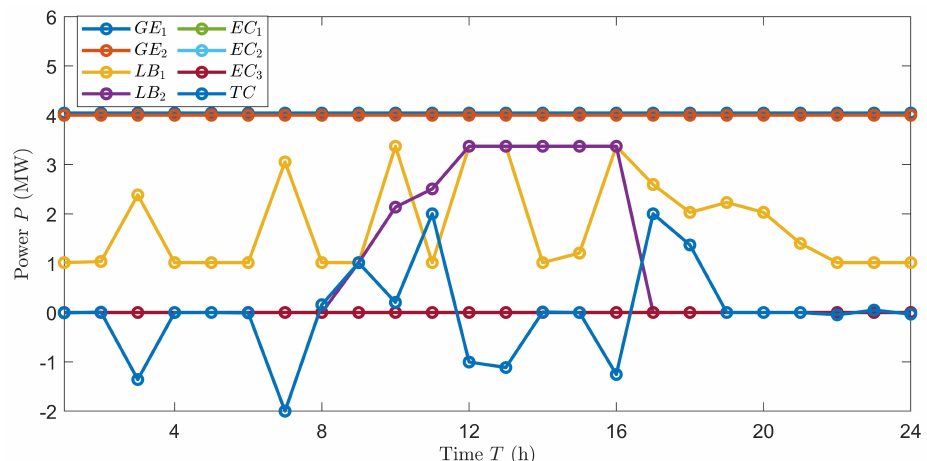
Figure 10. Equipment output (cooling season, determining electricity by heat).